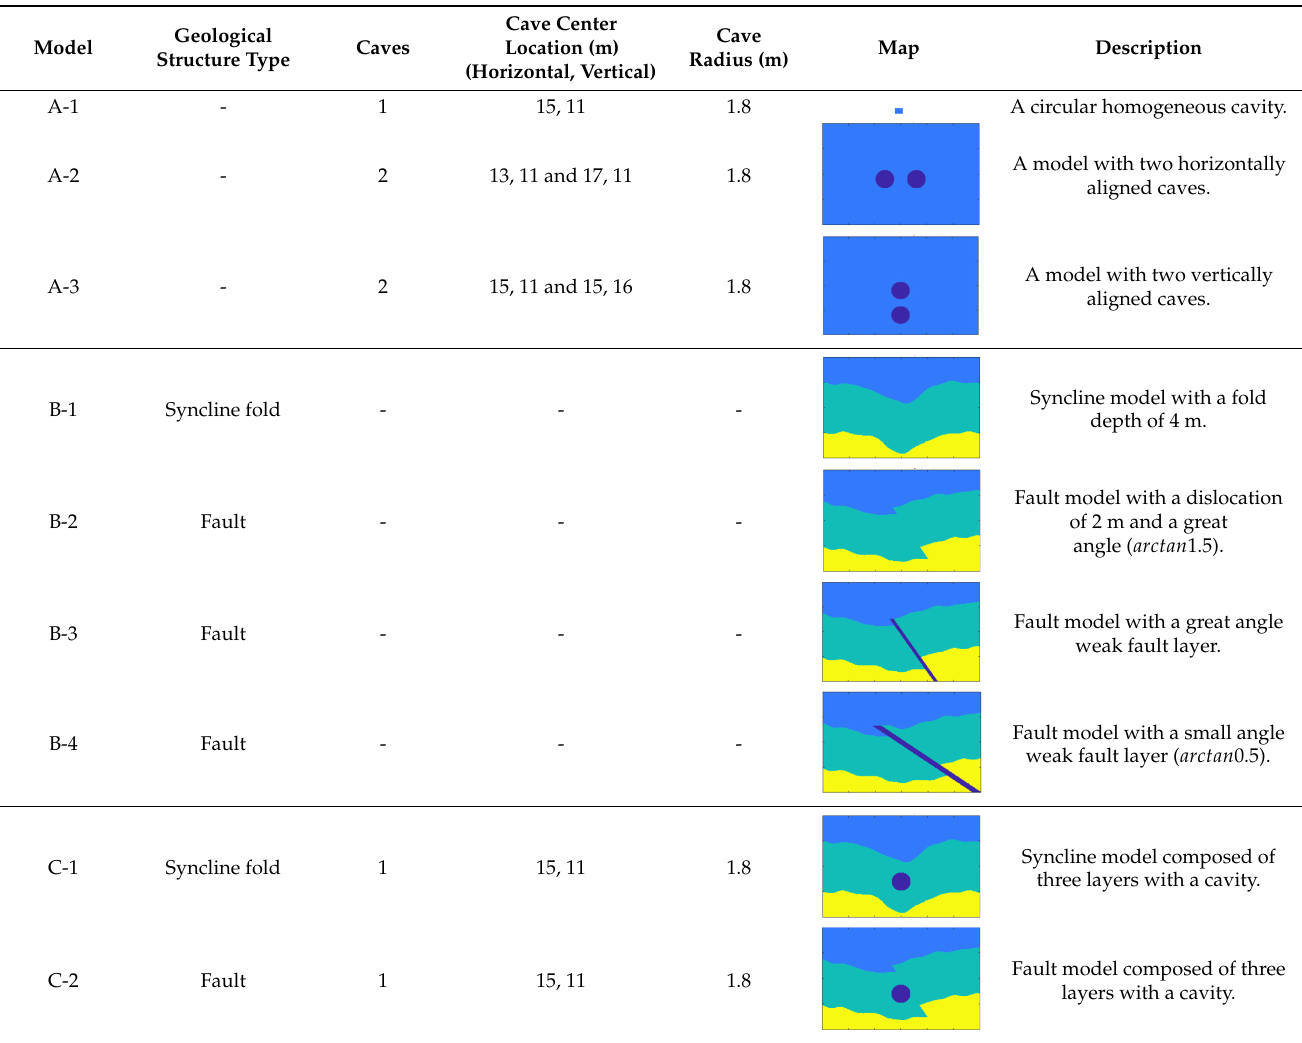
Table 2. Model list.